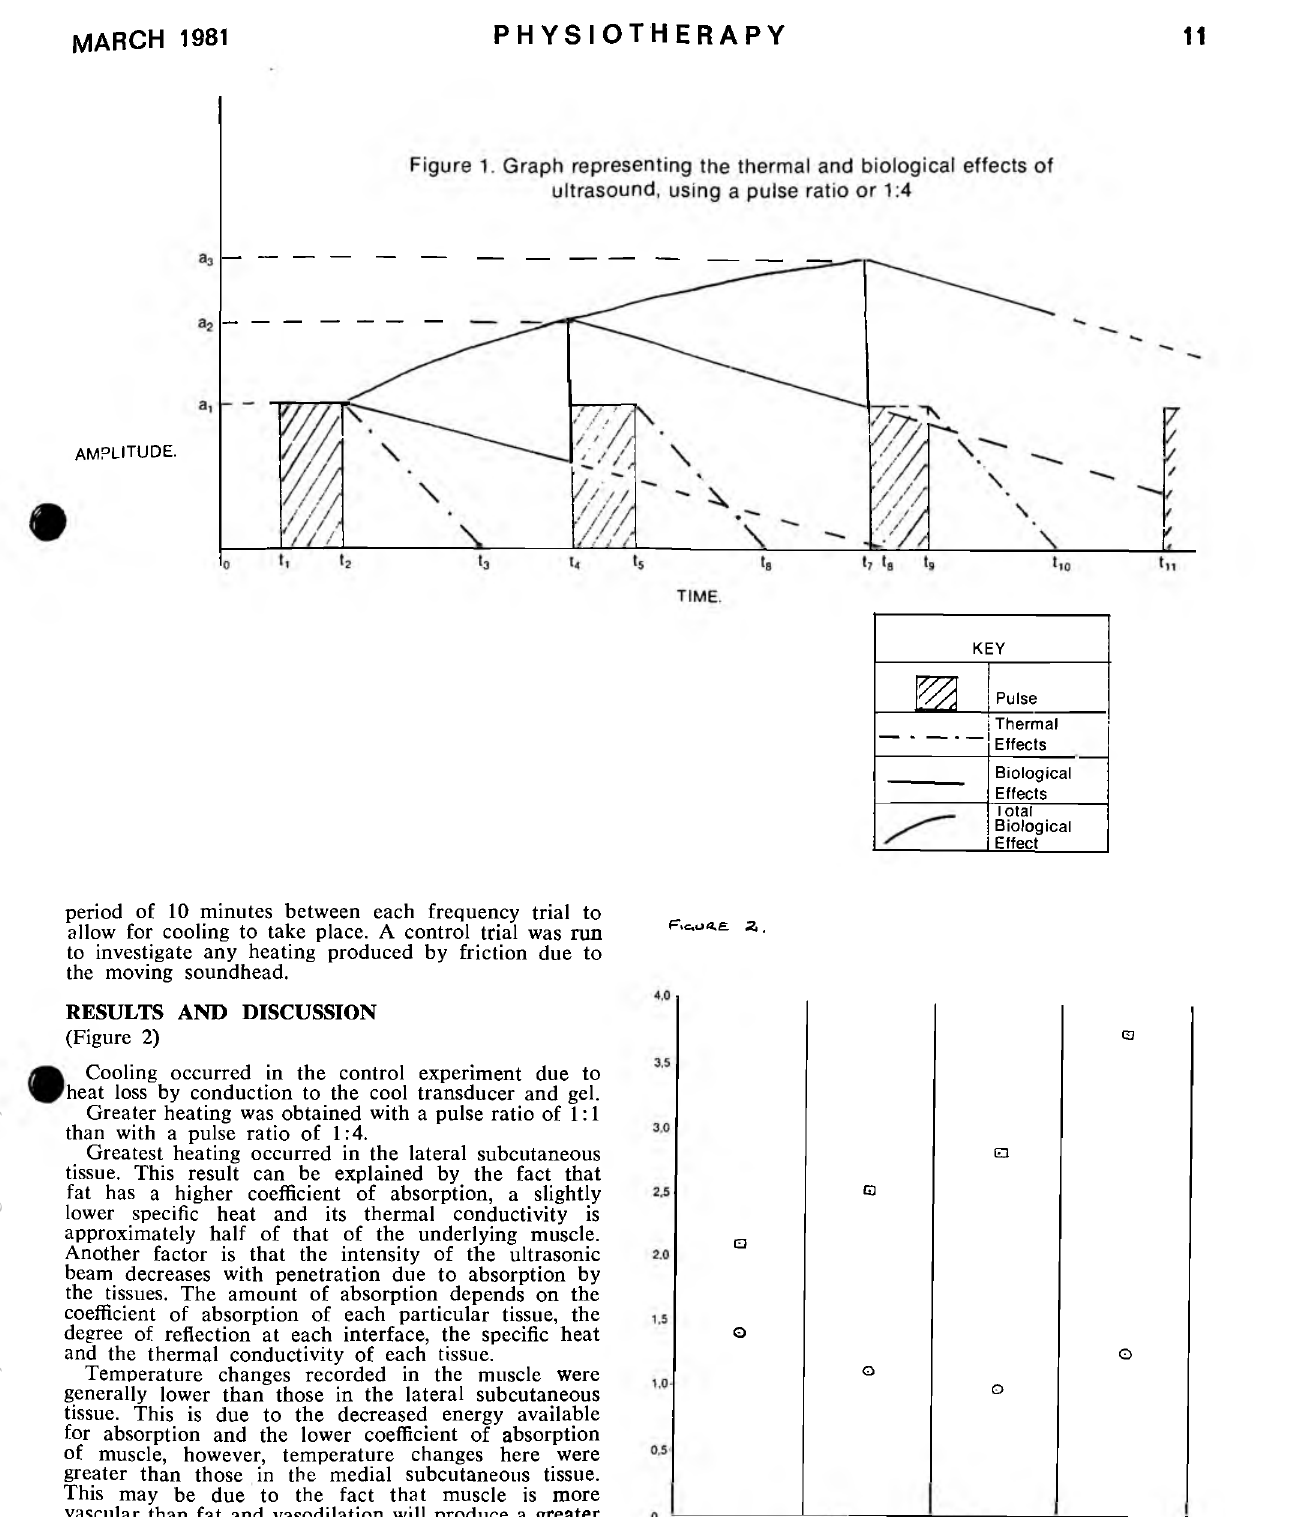
KEY % Pulse _ --------- Thermal Effects Biological Effects 1 otal Biological